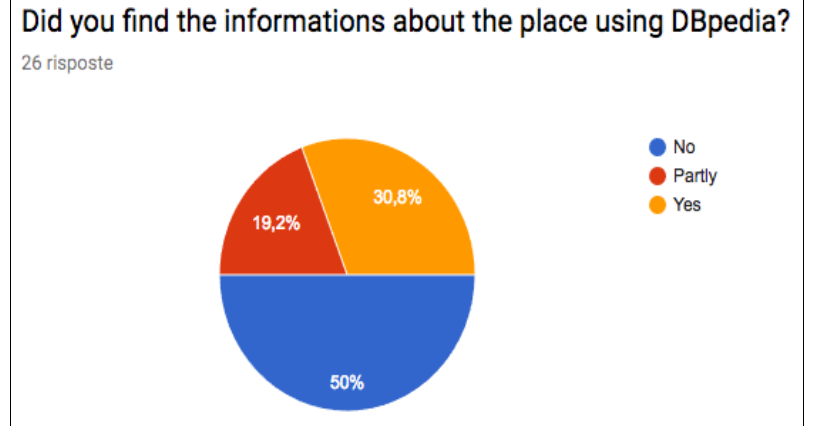
Figure 13. Information on the locations retrieved through DBpedia